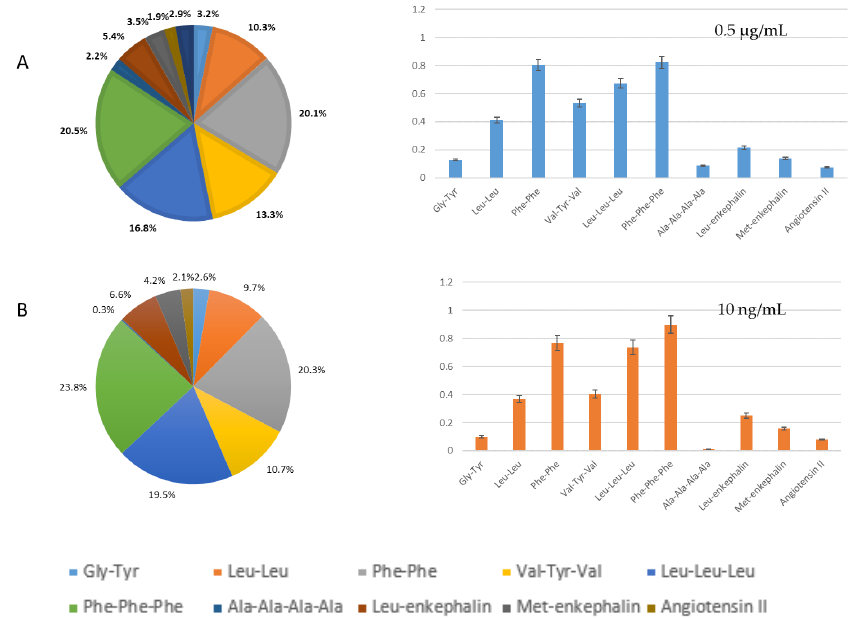
Figure 5. Repartition and recoveries of each peptide ( A ) in direct injection configuration 0.5 µg/mL and ( B ) in trapping configuration 10 ng/mL. Results are given as the ratio of compound area over internal standard one (A/A Met3 ).